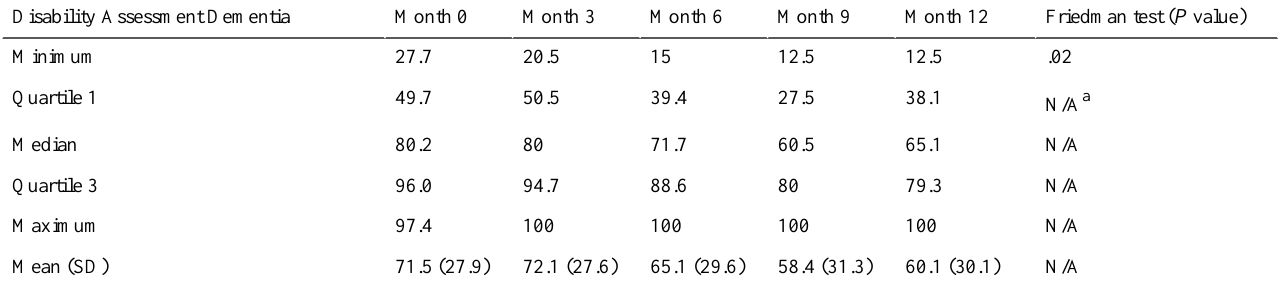
Table 8. People with dementia Disability Assessment Dementia score during the year